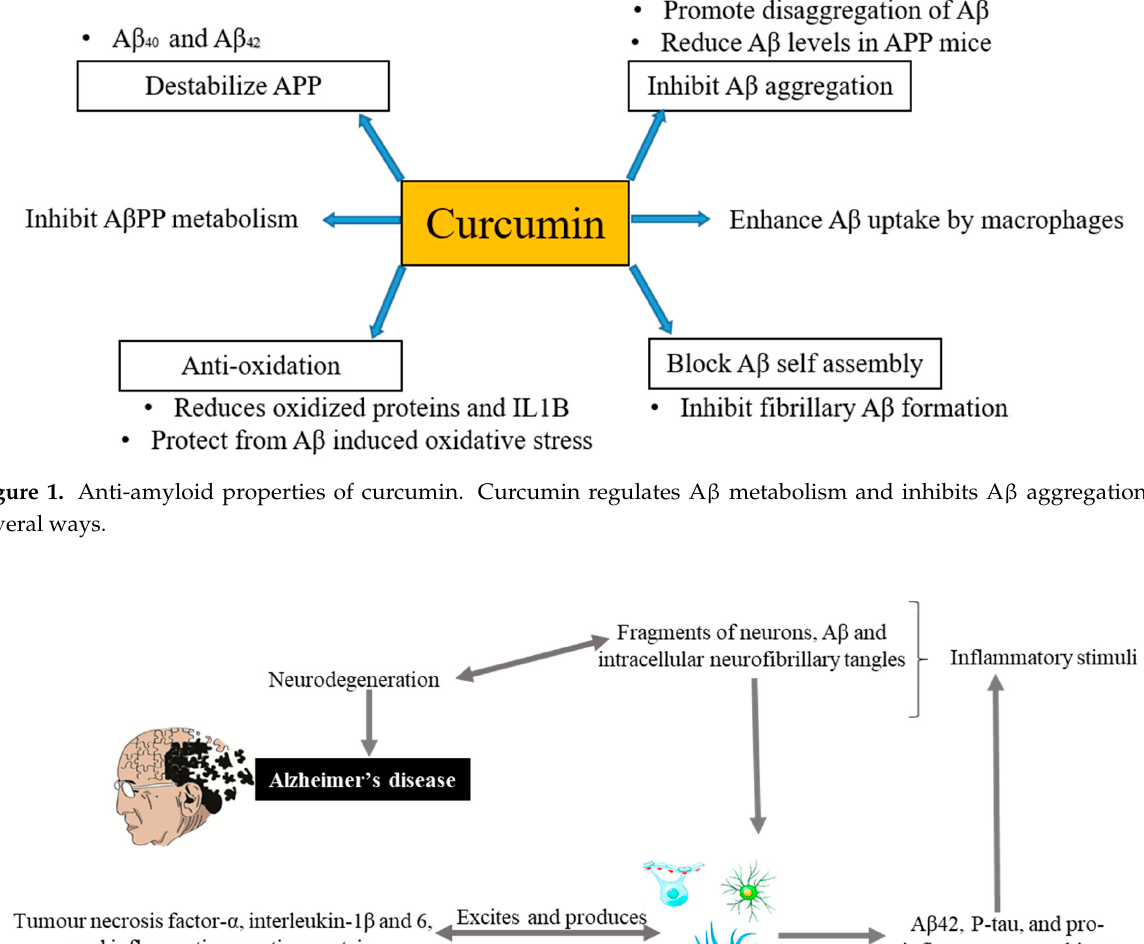
Figure 1. Anti-amyloid properties of curcumin. Curcumin regulates A β metabolism and inhibits A β aggregation in several ways.